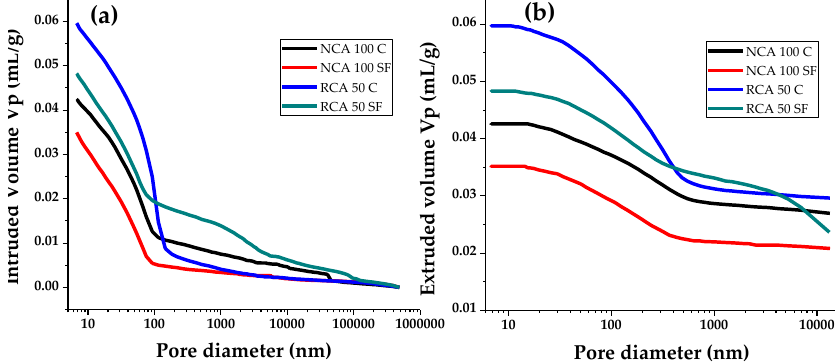
Figure 9. Mercury intrusion porosimetry, ( a ) intrusion and ( b ) extrusion.